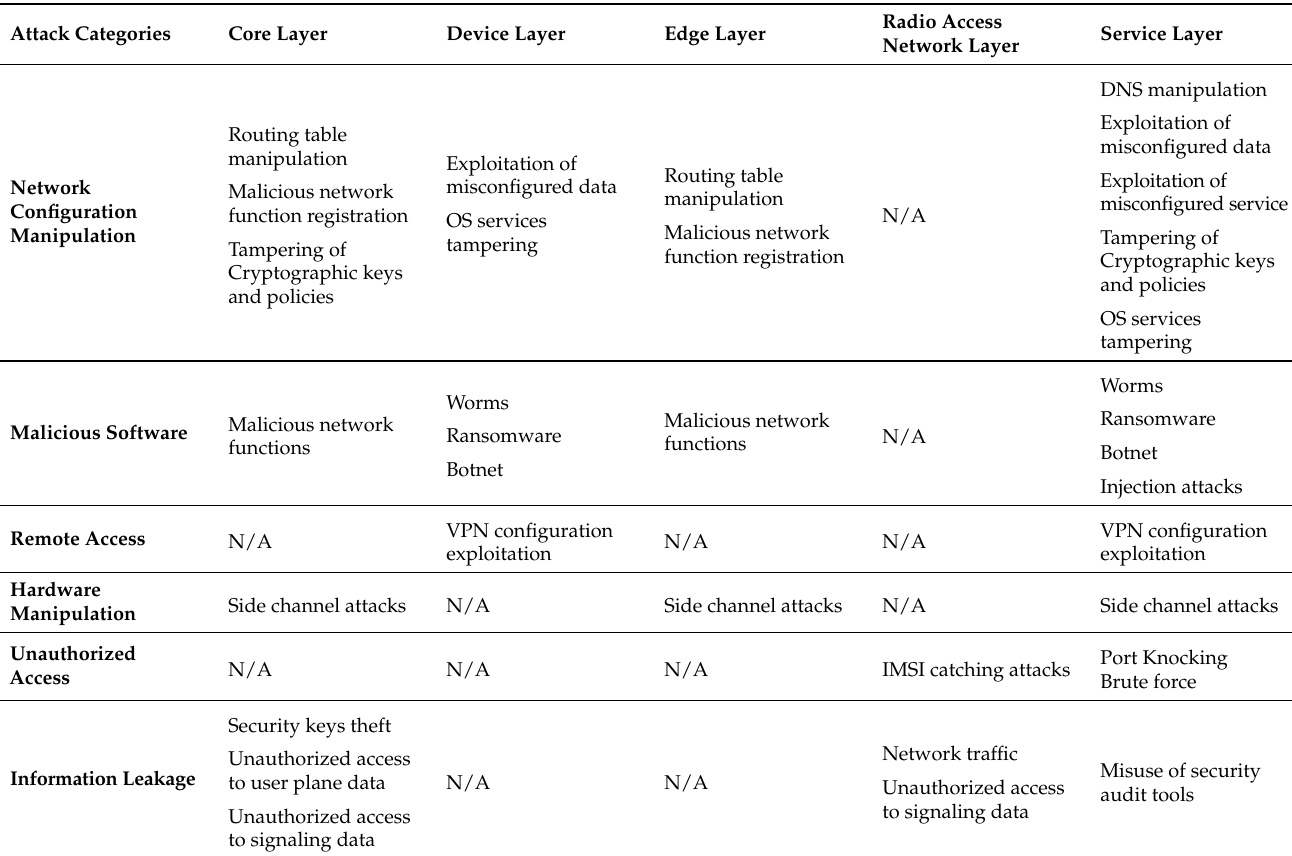
Table 2. Categories of 5G threats mapped with